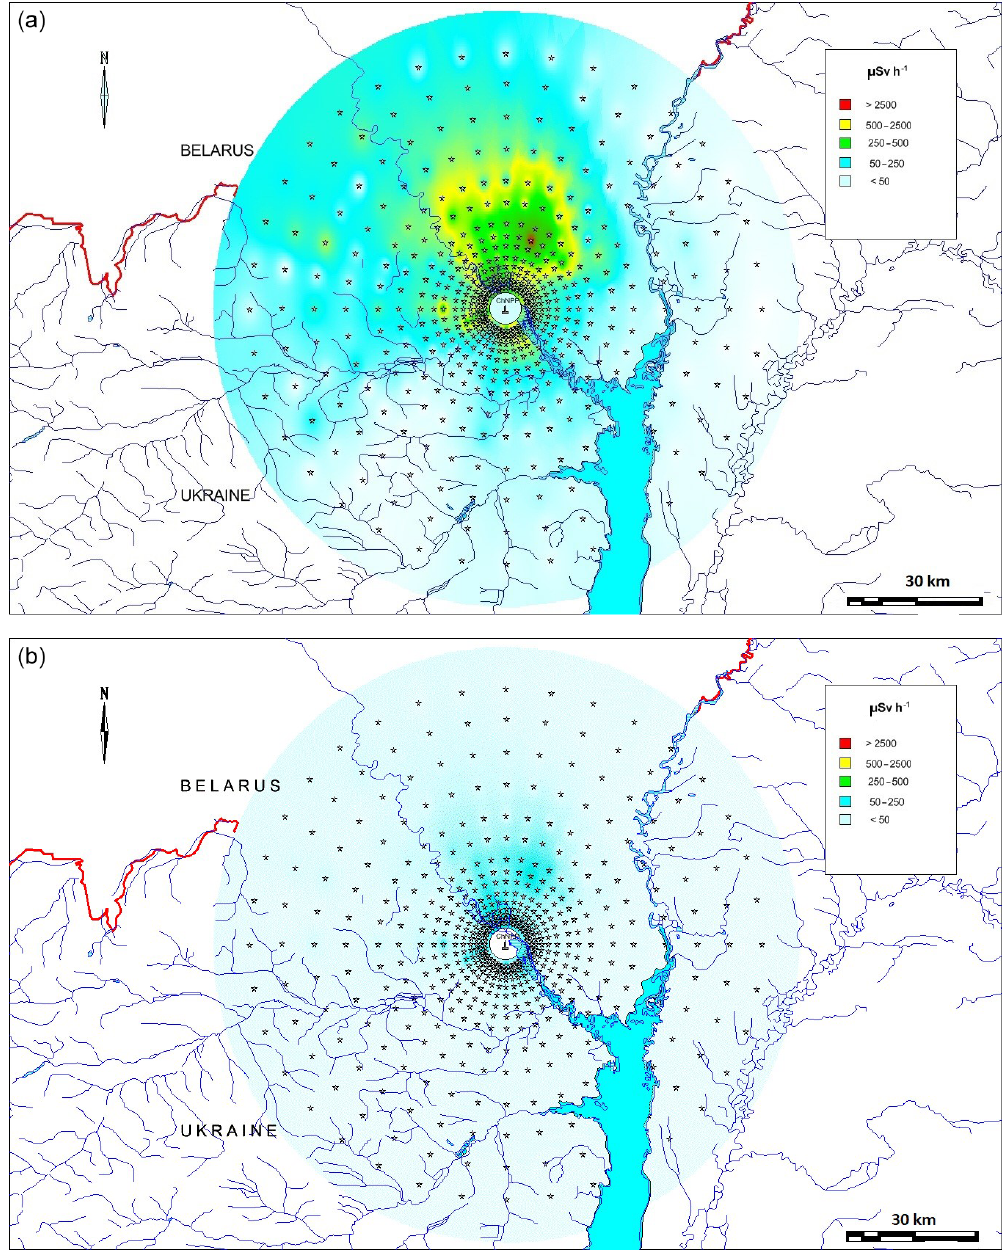
Figure 9. Spatial distribution, interpolated as for Fig. 8, of the effective dose rate within the 60km zone around the ChNPP on 10 May 1986 (a) and 10 August 1986 (b) . Note that no data were available for less than 5km from ChNPP, and no interpolation for this area has been